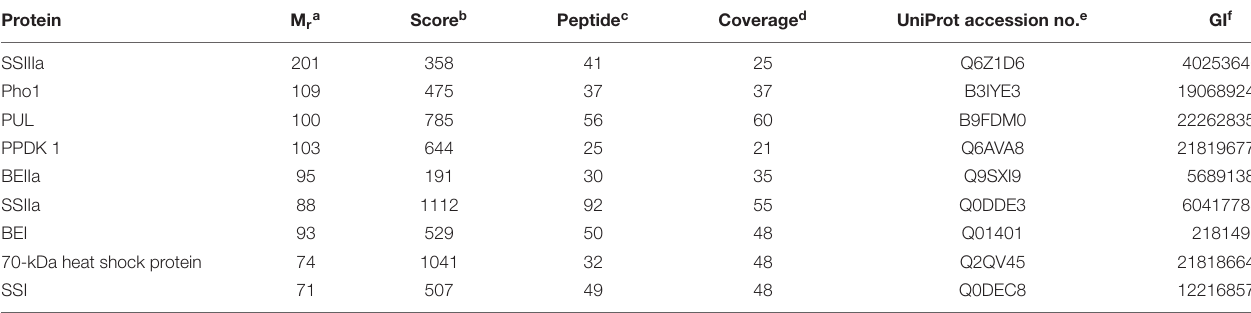
Protein M ra Score b Peptide c Coverage d UniProt accession no. e GI